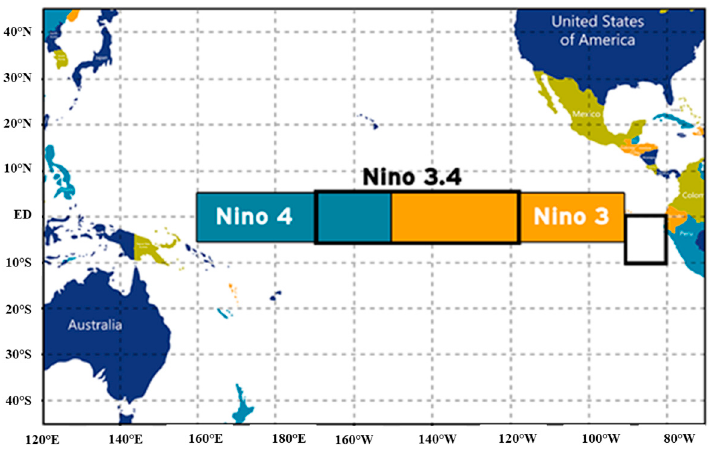
Figure 1. The presentation of ENSO regions.